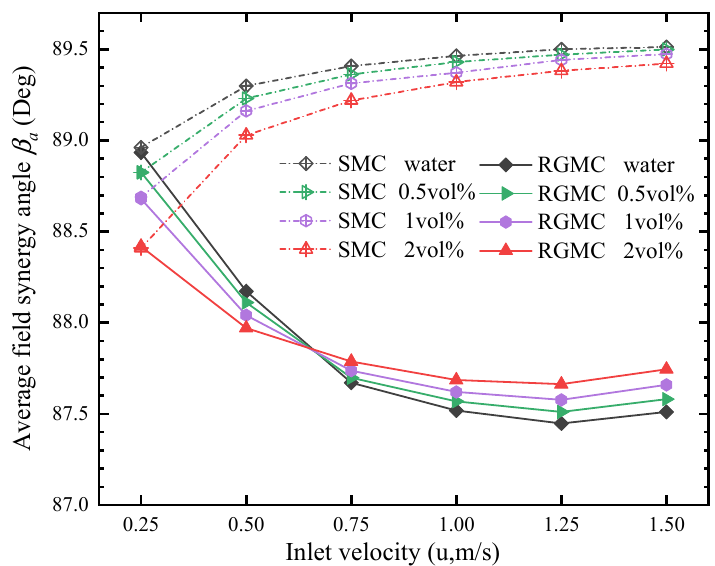
Figure 10. Variation of the average heat transfer field synergy angle β α .